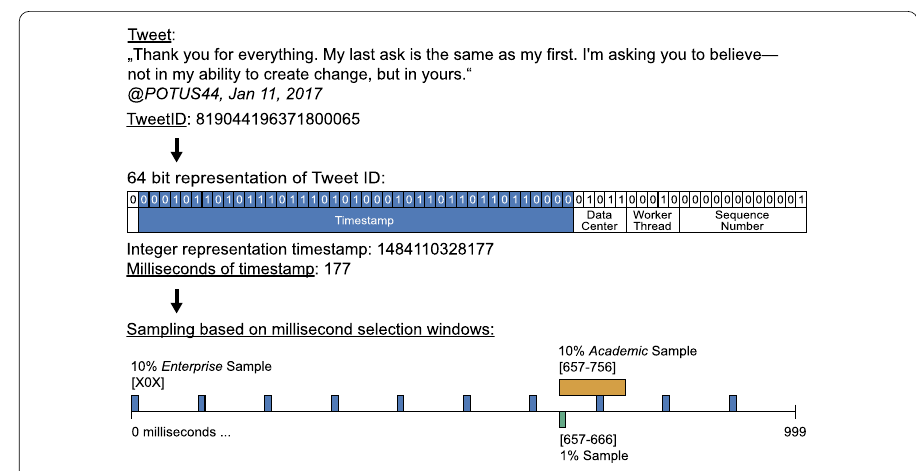
Figure 1 Twitter Sample API data sampling. Every Tweet gets a Tweet ID assigned by Twitter. Tweet IDs include the millisecond timestamp of when the Tweet arrives at a Twitter server. Whether a Tweet is in one